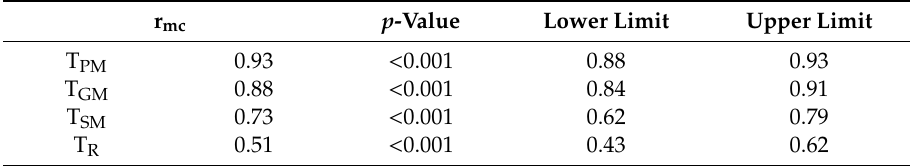
Table 2. Repeated-measures correlation coe ffi cient (r mc ) for body temperature readings in horses during Phases B (exercise on the treadmill) and D (cool-down walk). r mc p -Value Lower Limit Upper Limit T PM 0.93 < 0.001 0.88 0.93 T GM 0.88 < 0.001 0.84 0.91 T SM 0.73 <